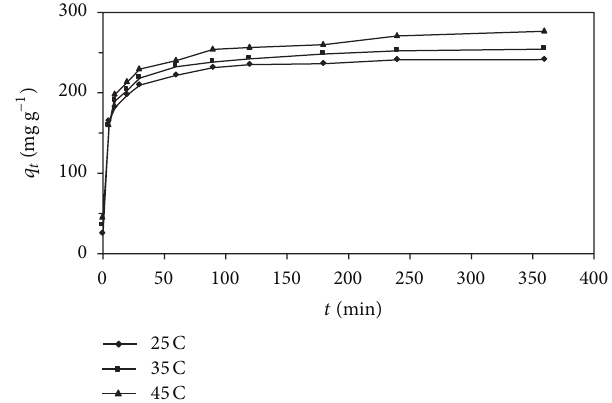
Figure 2: Effect of contact time for the adsorption of lead (II) ions onto the activated carbon (SAC2). ( C 𝑜 = 300mg L −1 ; 𝑚 = 50 mg; 𝑉 = 100 mL; pH = 5.5; agitation rate